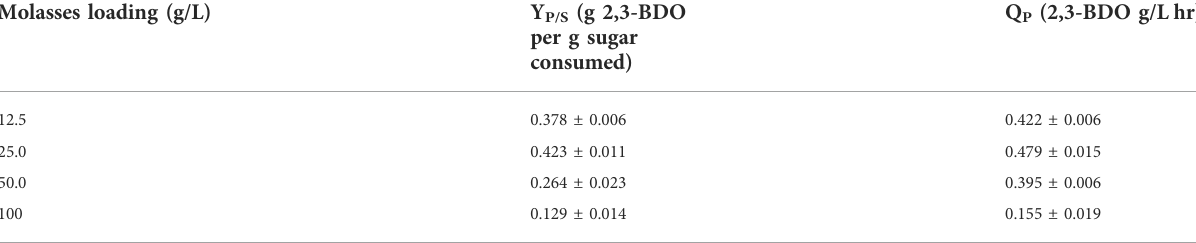
TABLE 3 Highest 2,3-butanediol product yield and volumetric productivity obtained during oxygen limited fermentation of molasses media. Molasses loading